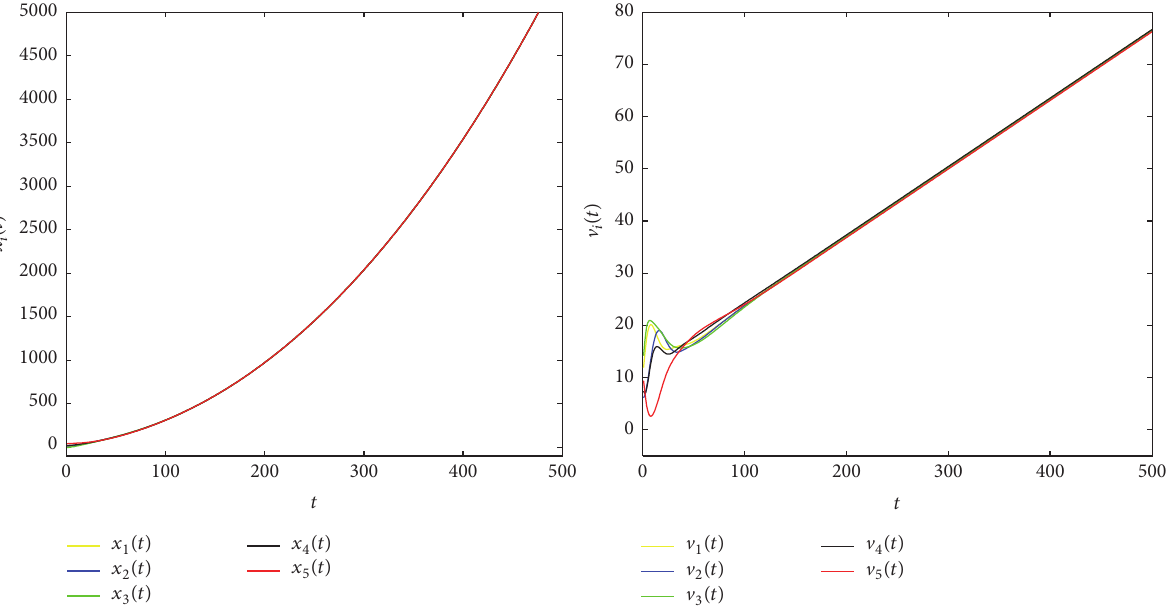
Figure 5: 𝑥 𝑖 (𝑡) and V 𝑖 (𝑡) of each agent with protocol (22), 𝛼 = 1.3